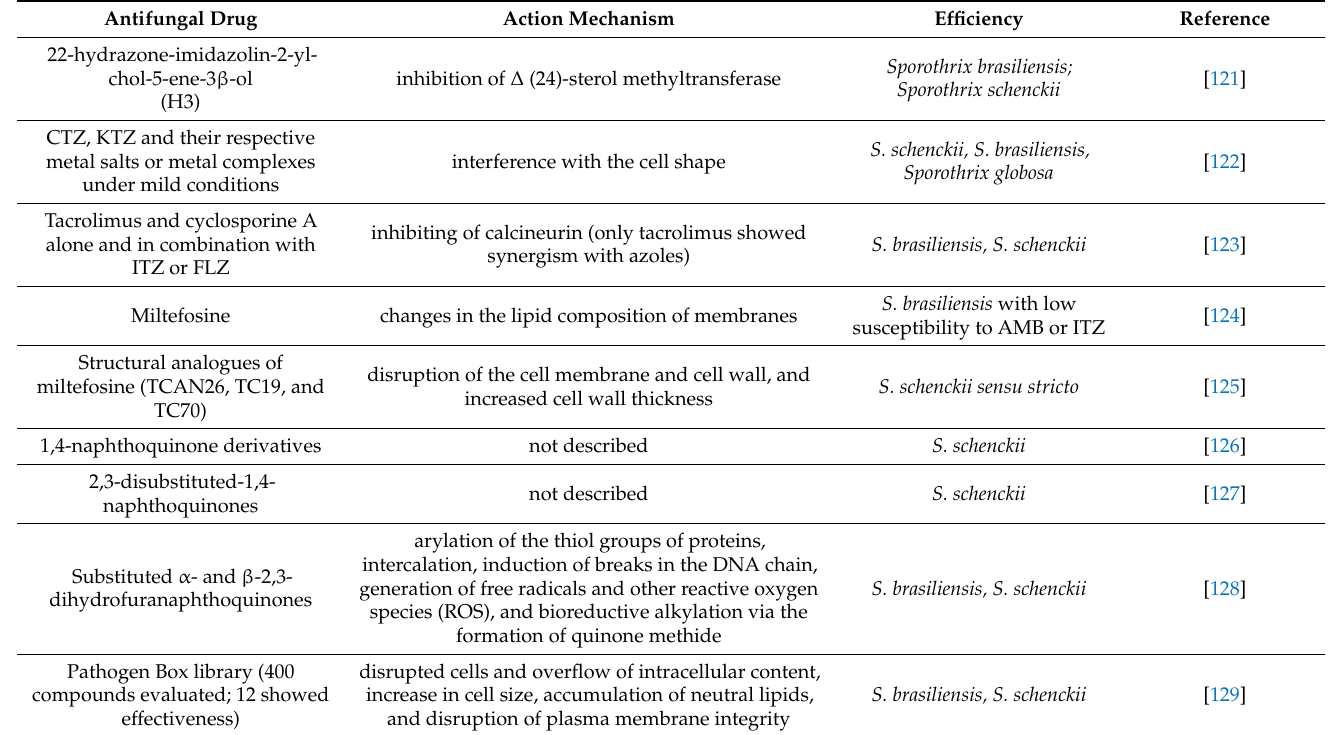
Table 5. New antifungal drugs for potential use in the treatment of